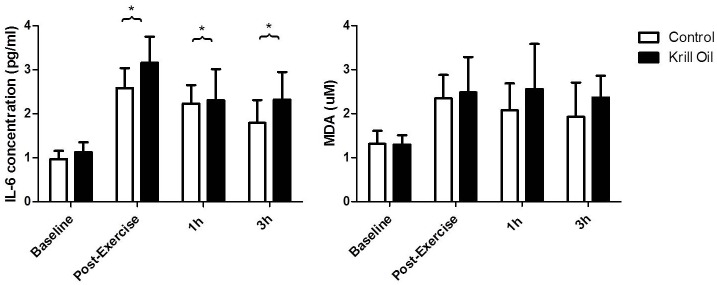
The effect of 6 weeks krill oil/placebo supplementation on plasma IL-6 and TBARS (expressed as MDA concentration) before and after exercise.* denotes a significant difference (P<0.05) from baseline in both groups.